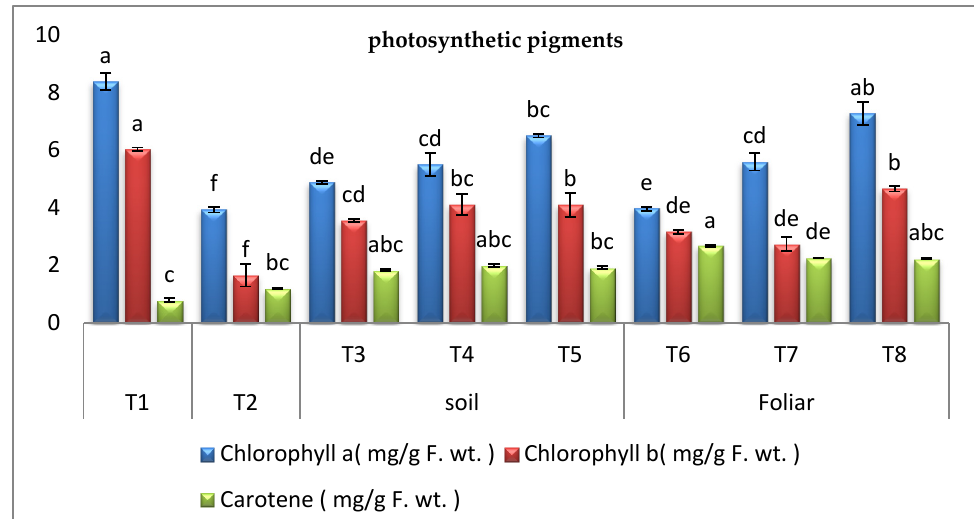
Figure 3. Effect of cyanobacteria on photosynthetic pigments of the infected pepper plant with Fusarium wilt (T1-healthy control, T2-infected control, T3-infected plants treated with D. muscorum soil, T4-infected plants treated with A. oryzae soil, T5-infected plants treated with A. platensis soil, T6-infected plants treated with D. muscorum foliar spray, T7-infected plants treated with A. oryzae foliar spray and T8-infected plants treated with A. platensis foliar application.) (Data represent mean ± SD, n = 3), (a–f Letters revered to significant in statically analysis). Table 2. Effect of cyanobacteria on osmolytes (soluble sugar, soluble protein, and proline) mg g − 1 DW) contents of the infected pepper plant with Fusarium wilt. Data presented as means ± SD (n = 3). Data followed by letters are significantly different in the LSD test at p ≤